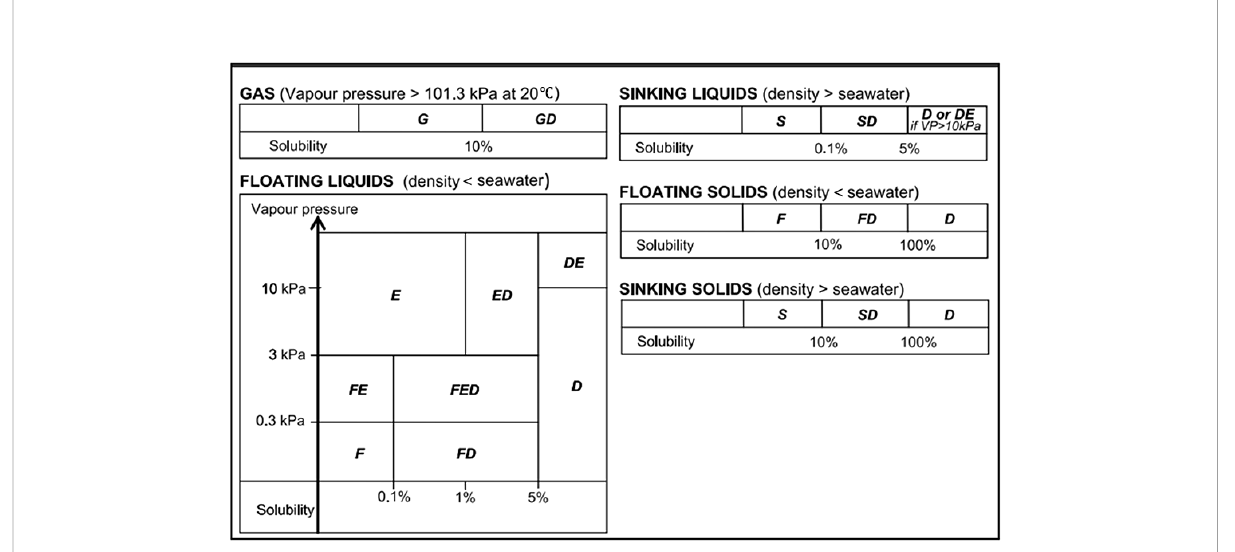
FIGURE 1 SEBC classi fi cation of HNS spills at sea. (adopted from the Bonn Agreement,